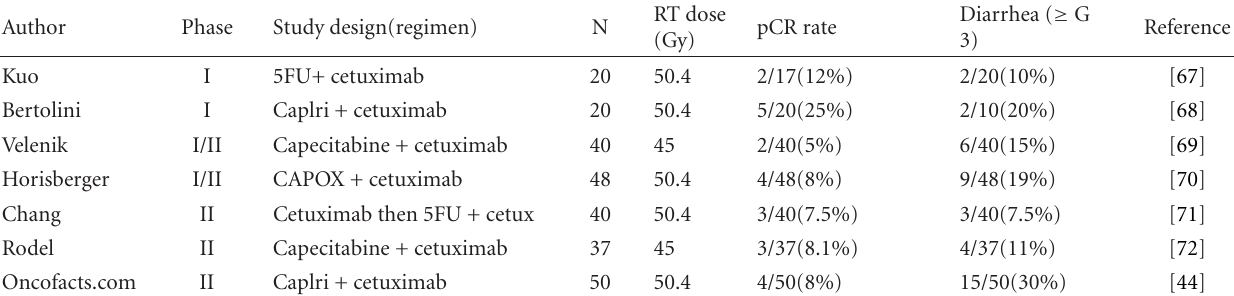
Table 4: Clinical trials of cetuximab in preoperative treatment of rectal